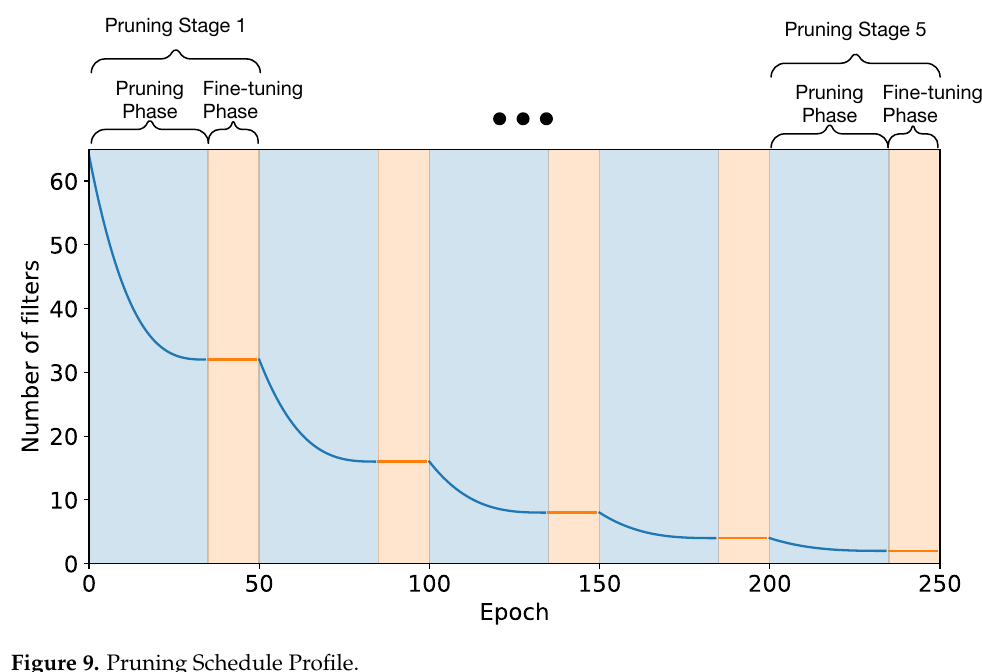
Figure 9. Pruning Schedule Profile.